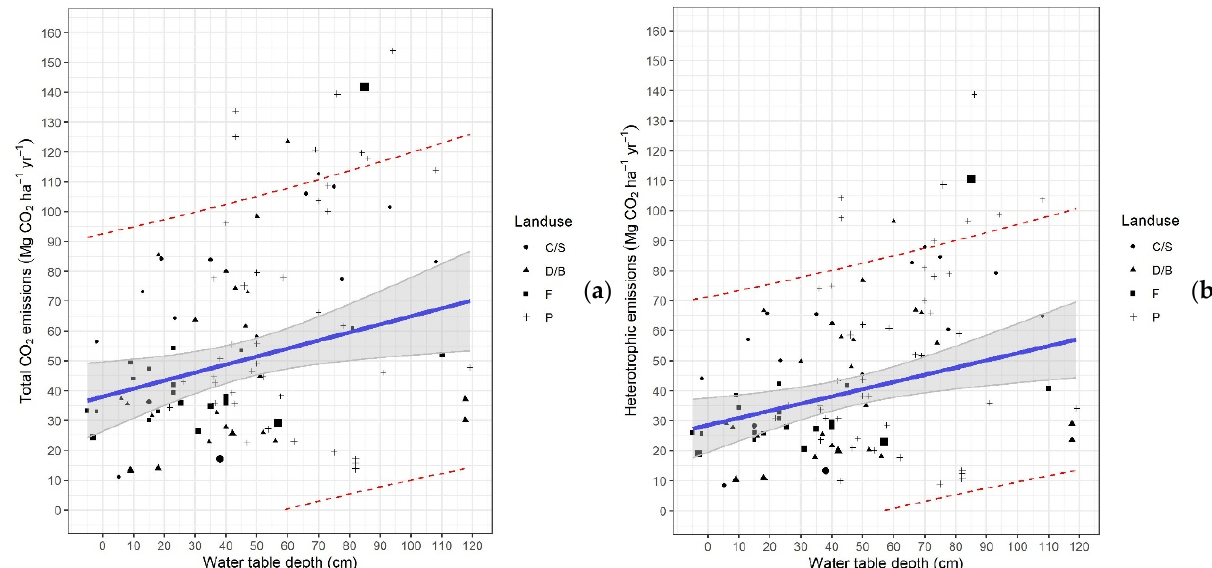
Figure 4. Relationship between water table depth and ( a ) total CO 2 emissions and ( b ) heterotrophic emissions of all land uses. Solid blue lines represent the estimates of the population mean, shaded grey bands indicate the 95% CIs of population mean estimates, dashed red lines indicate the 95% prediction intervals for the potential CO 2 values of future samples, while the four shapes (circles, triangles, squares, and crosses) indicate the observation values in the land use classes where C/S = cropping/shrubland, D/B = drained/burnt, F = forest, and P = plantation.